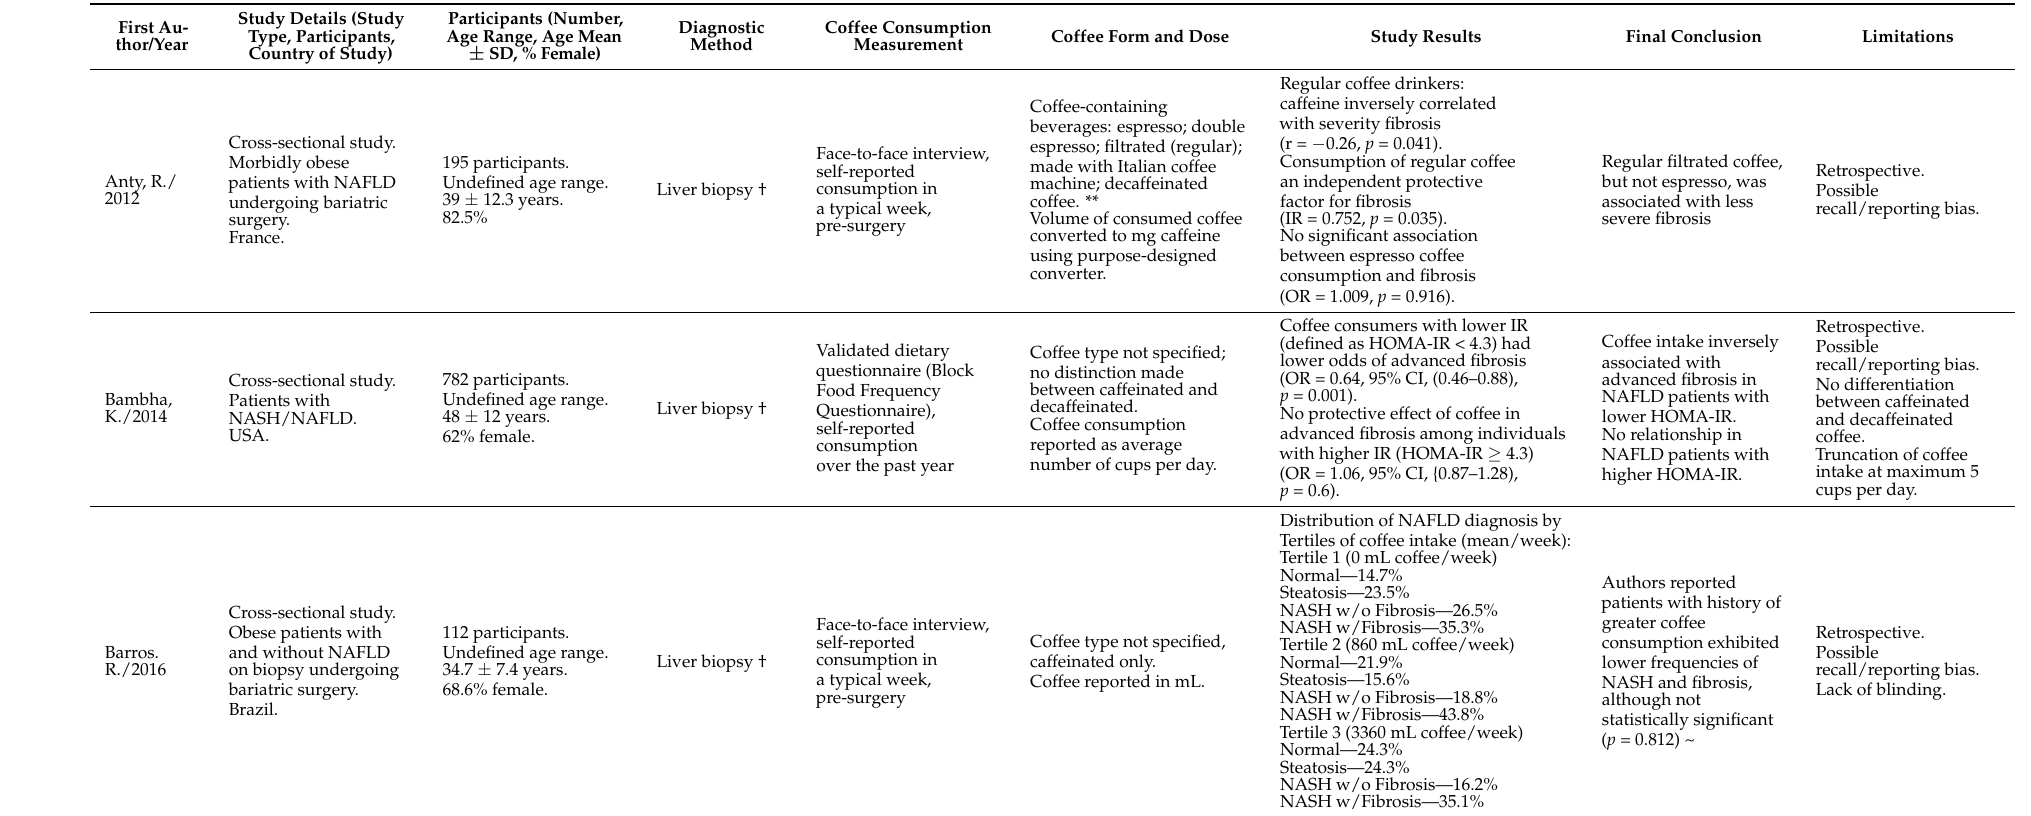
Table 1. Summary of characteristics of all studies included in this